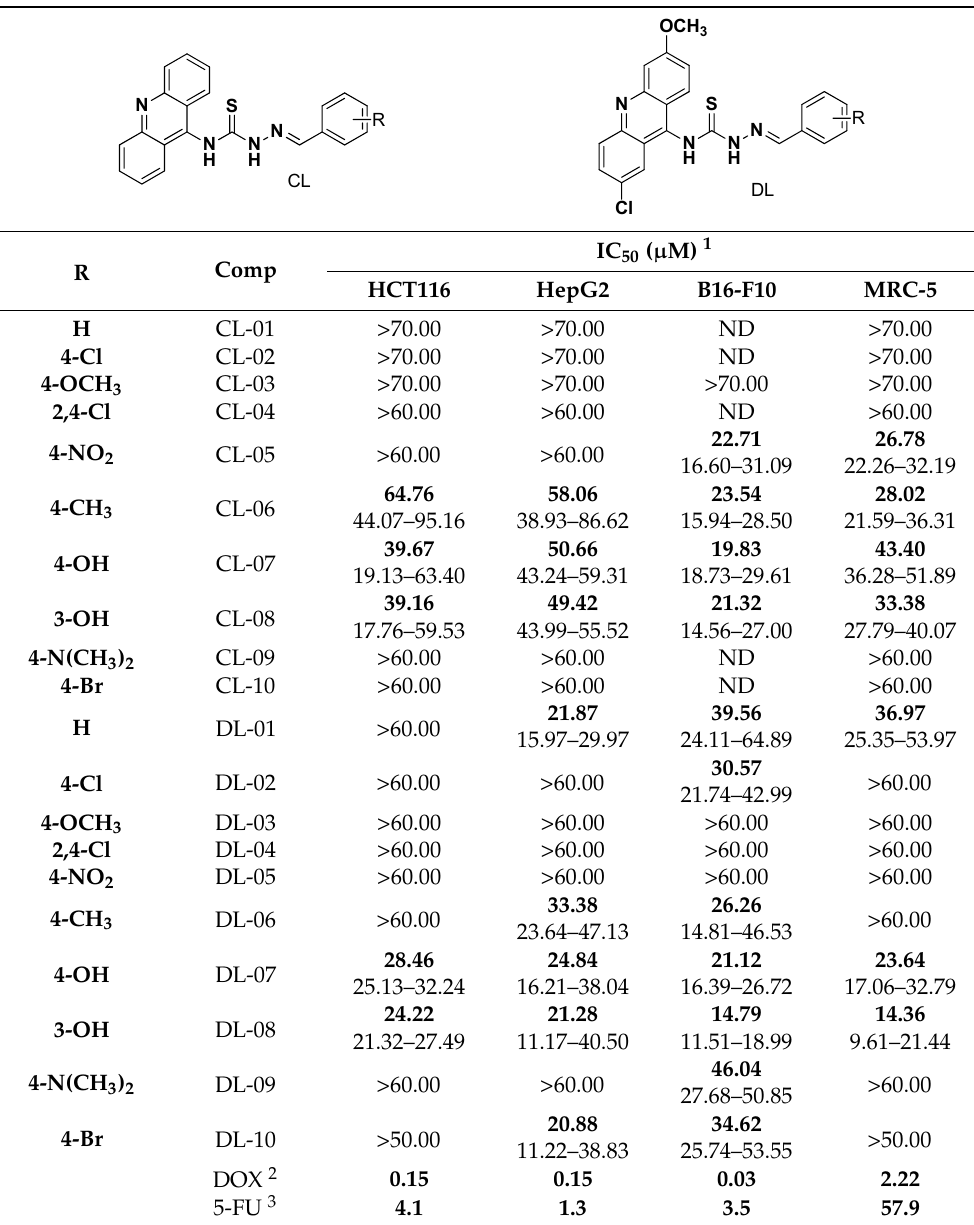
Table 1. Cytotoxicity activity of new acridine–thiosemicarbazone derivatives.